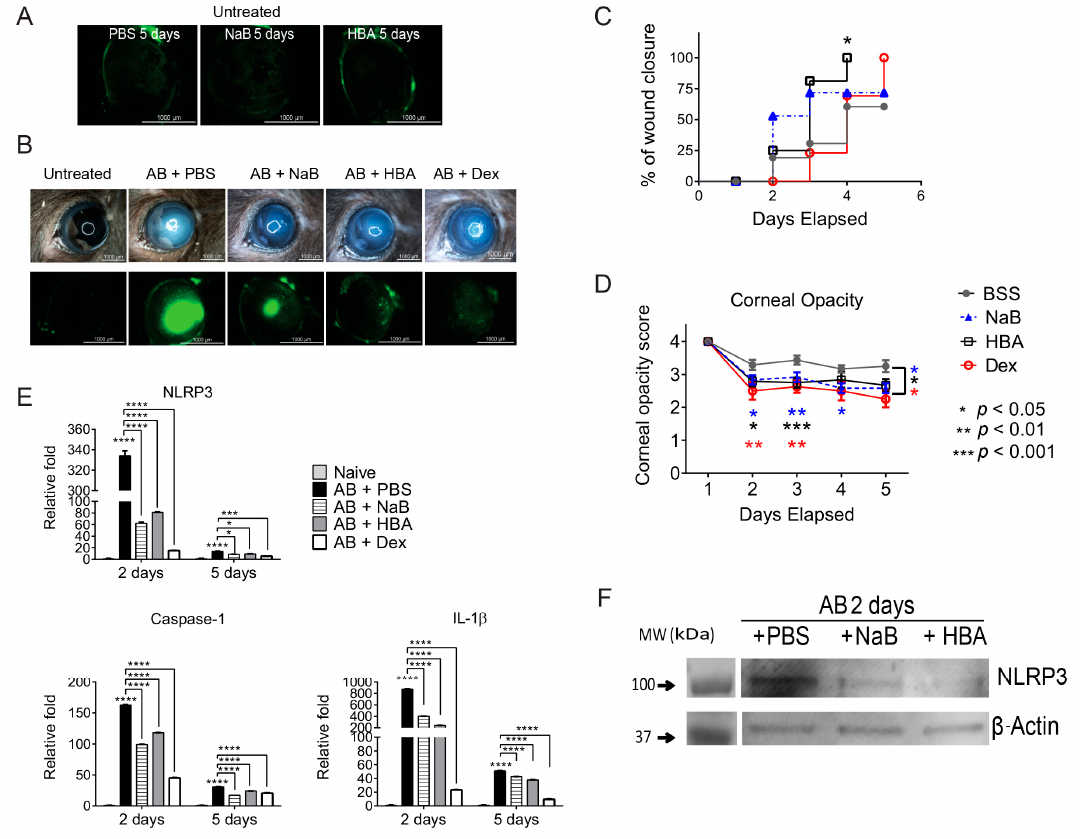
Figure 5. Sodium butyrate (NaB) and hydroxybutyric acid (HBA) eyedrops improve clinical parameters and decrease inflammation in animals subjected to alkali burns (AB). ( A ) Digital images of corneas stained with 0.1% sodium fluorescein demonstrating intact corneal epithelium after topical NaB, HBA or balanced salt solution (BSS) treatment for 5 days quater in die (QID) in untreated mice ( n = 5 animals/group). Scale bar: 1000 µm; ( B ) Representative color digital images used to score corneal opacity ( top row ) and representative fluorescein stained corneas used to create wound closure rate ( bottom row ) at 5 days ( n = 15 animals/group) after alkali burn. Scale bar: 1000 µm; ( C ) Corneal opacity in corneas subjected to alkali burn and topically treated with either NaB, HBA, or BSS and compared with dexamethasone (Dex) ( n = 15 animals/group); ( D ) Wound closure rate in corneas subjected to alkali burn and topically treated with either NaB, HBA, or BSS and compared with Dex ( n = 15 animals/group); ( E ) Mean ± SEM of results of gene expression analysis of NLRP3 , Caspase-1 , and IL-1 β in whole cornea of animals subjected to alkali burn for 2 or 5 days and topically treated with either NaB, HBA, or BSS and compared with Dex ( n = 5 animals/group). * p < 0.05, *** p < 0.001, **** p < 0.0001. ( F ) Representative digital images of western blot of NLRP3 and β -actin in cornea epithelium of animals subjected to alkali burn for 2 days and topically treated with either NaB, HBA, or BSS ( n = 12 animals/3 samples/group).